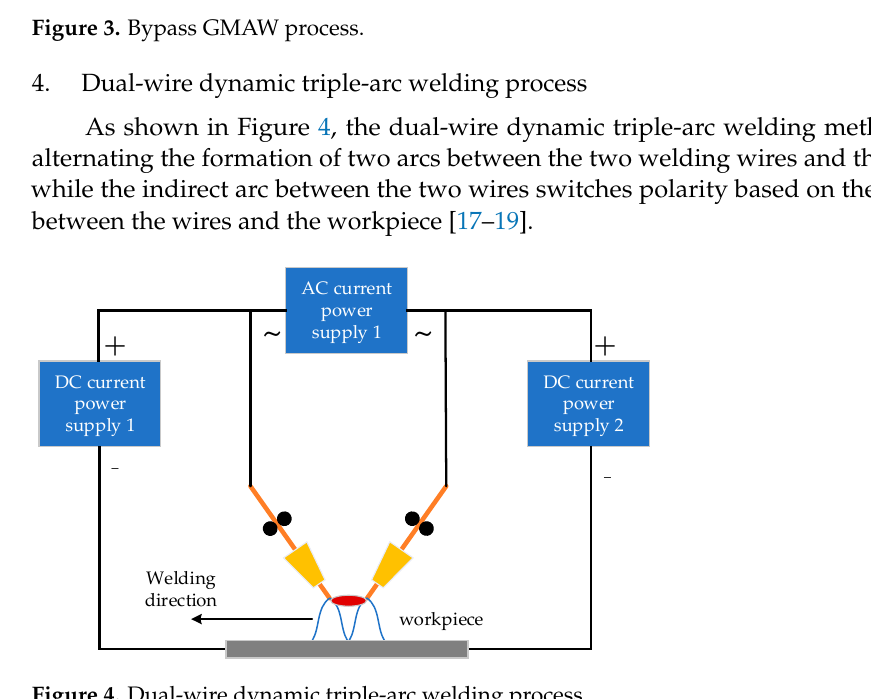
Figure 3. Bypass GMAW process.